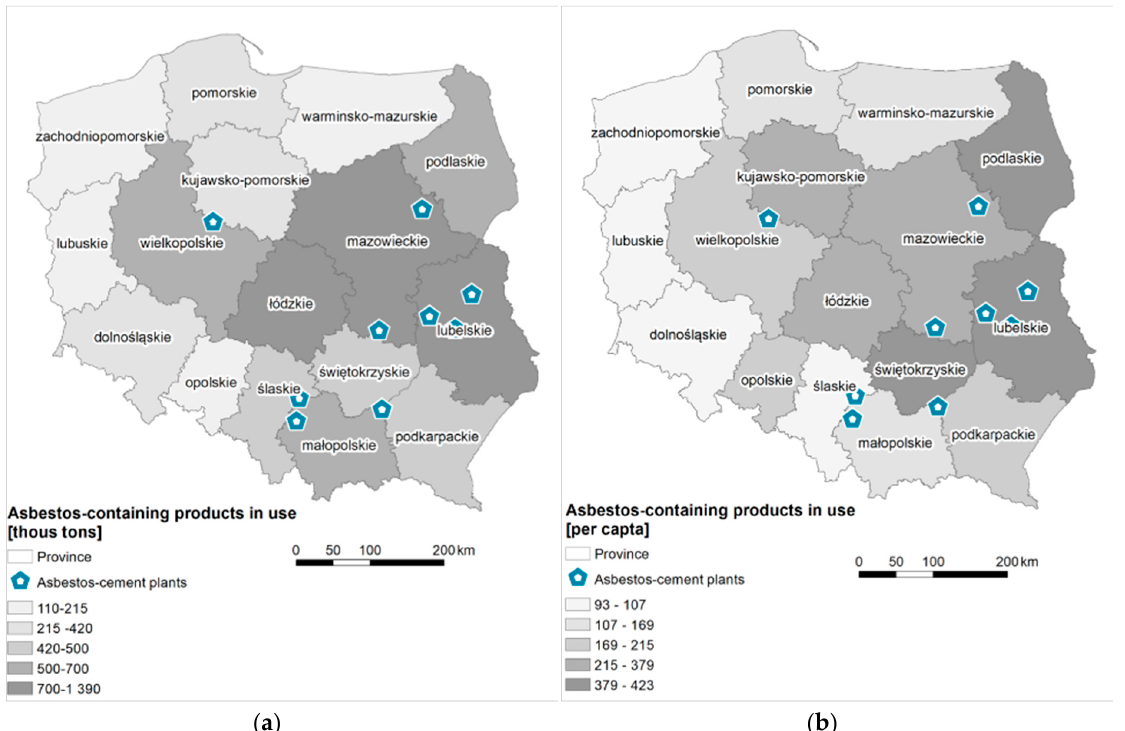
Figure 1. ( a ) The quantity of asbestos-cement roofing in Poland (tons); ( b ) The quantity